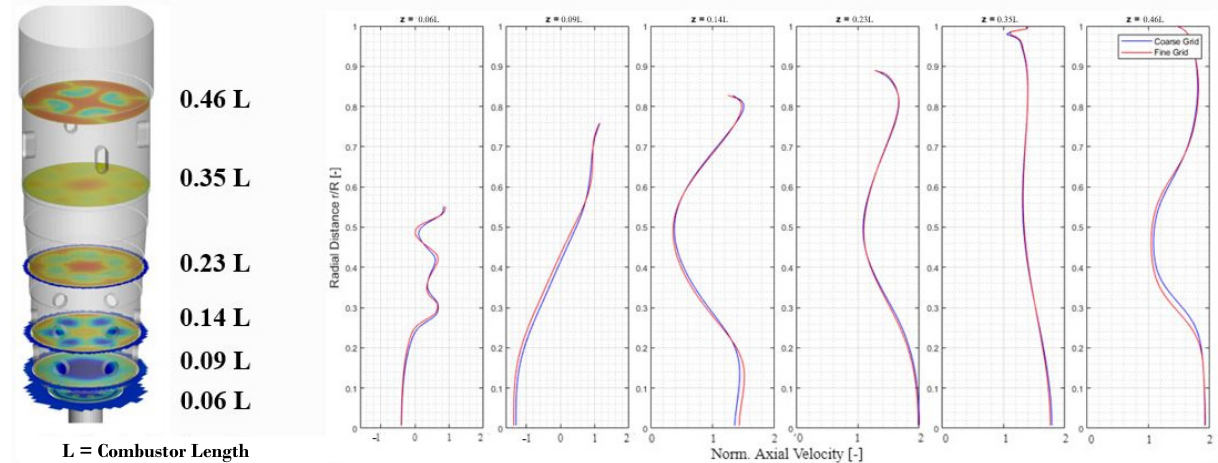
Figure 5. Normalized axial velocity mean radial distribution at different axial positions for base and refined grid.